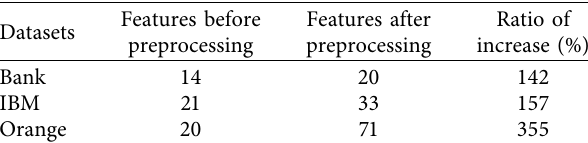
Table 6: Features amount before and after